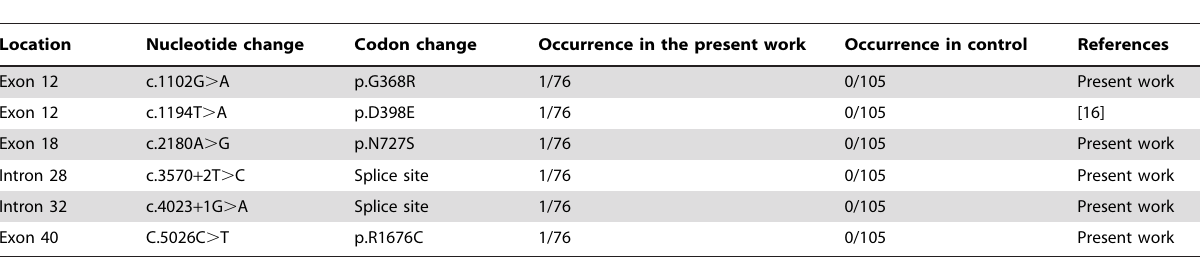
Table 1. Probable-pathogenic variants of OTOF identified in 76 patients.